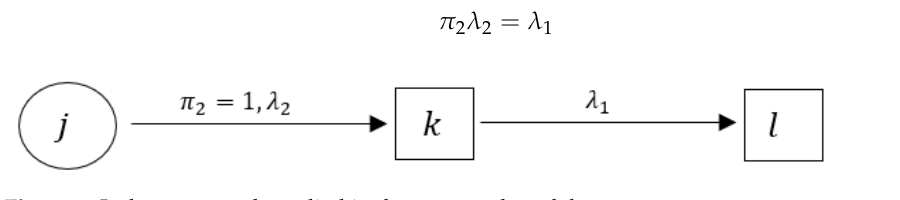
Figure 2. Jackson network studied in the proposed model.